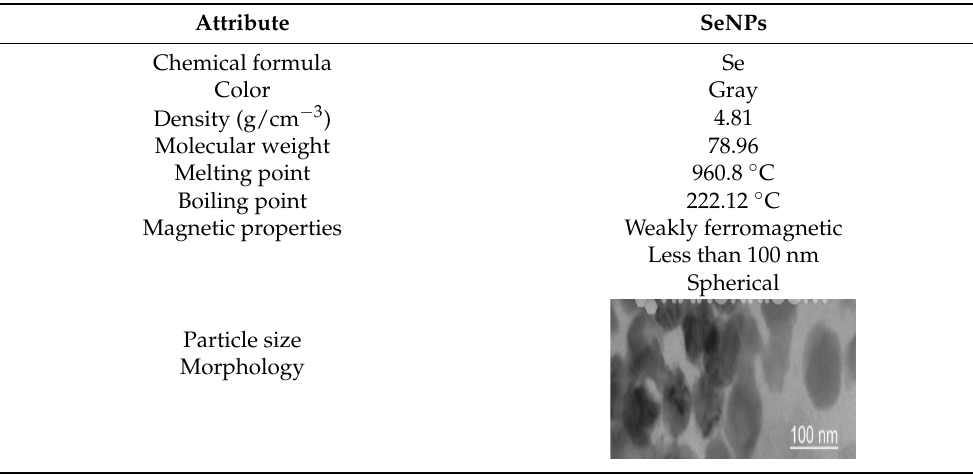
Table 5. Physicochemical characteristics of selenium nanoparticles used for foliar fertilization of the grass ( Festuca arundinacea Schreb. ) in a 90-day greenhouse experiment.